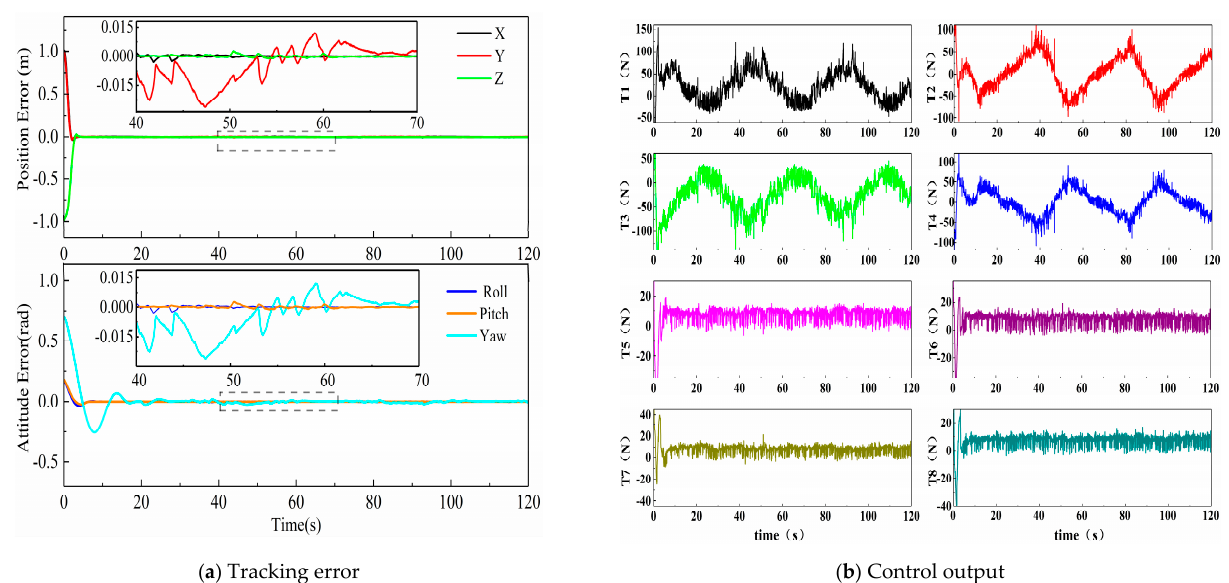
Figure 6. The control effect of the compared method under Case 2.